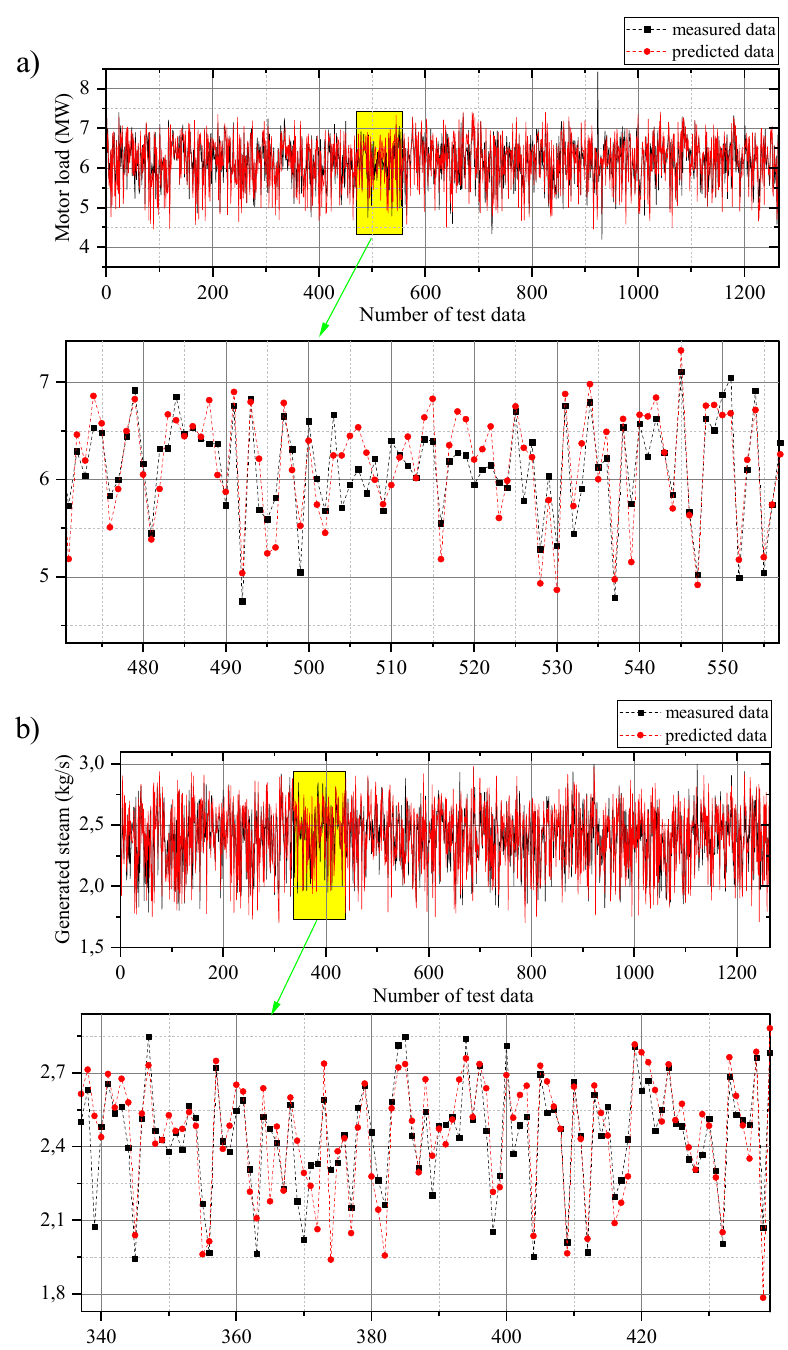
Figure 16. Test samples of genetic algorithm (GA) to estimate refining motor load ( a ), and refining steam generation ( b ).